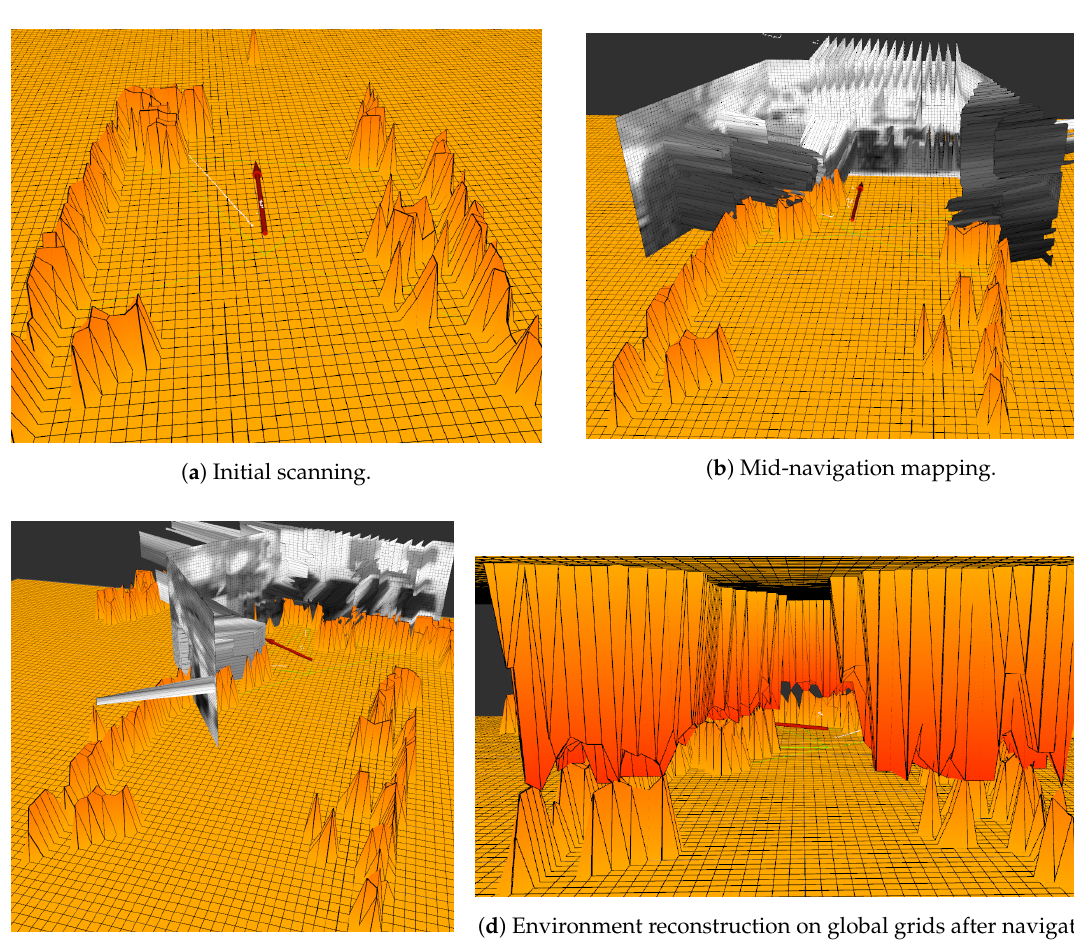
Figure 15. Results of the navigation